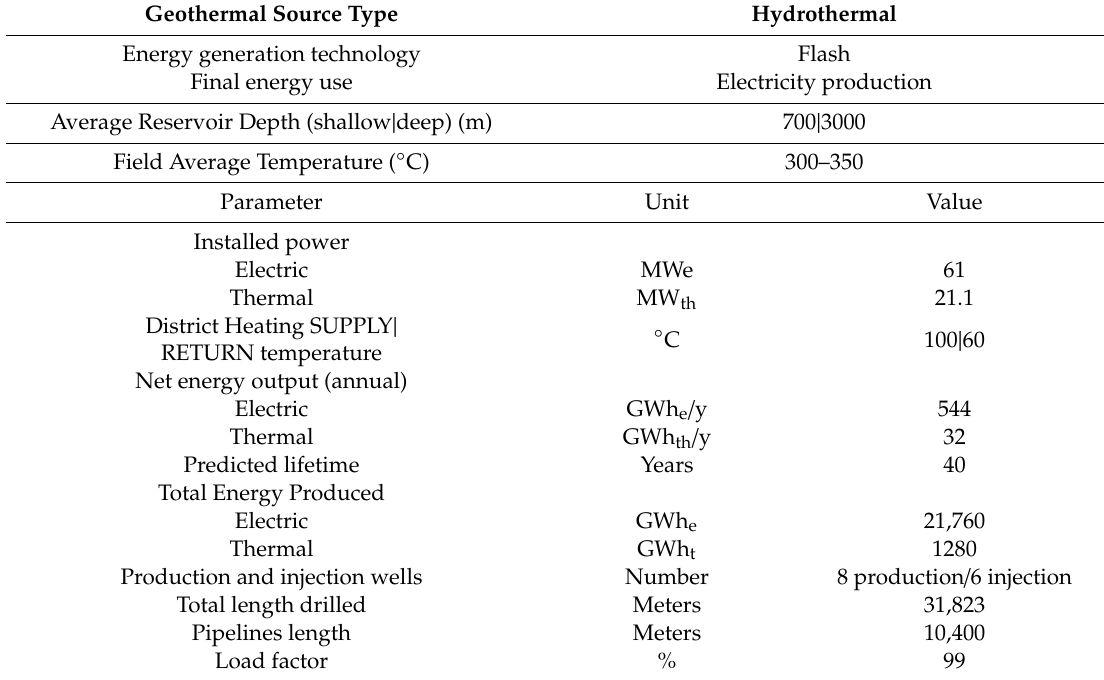
Table 1. Bagnore power plant system LCA key modelling